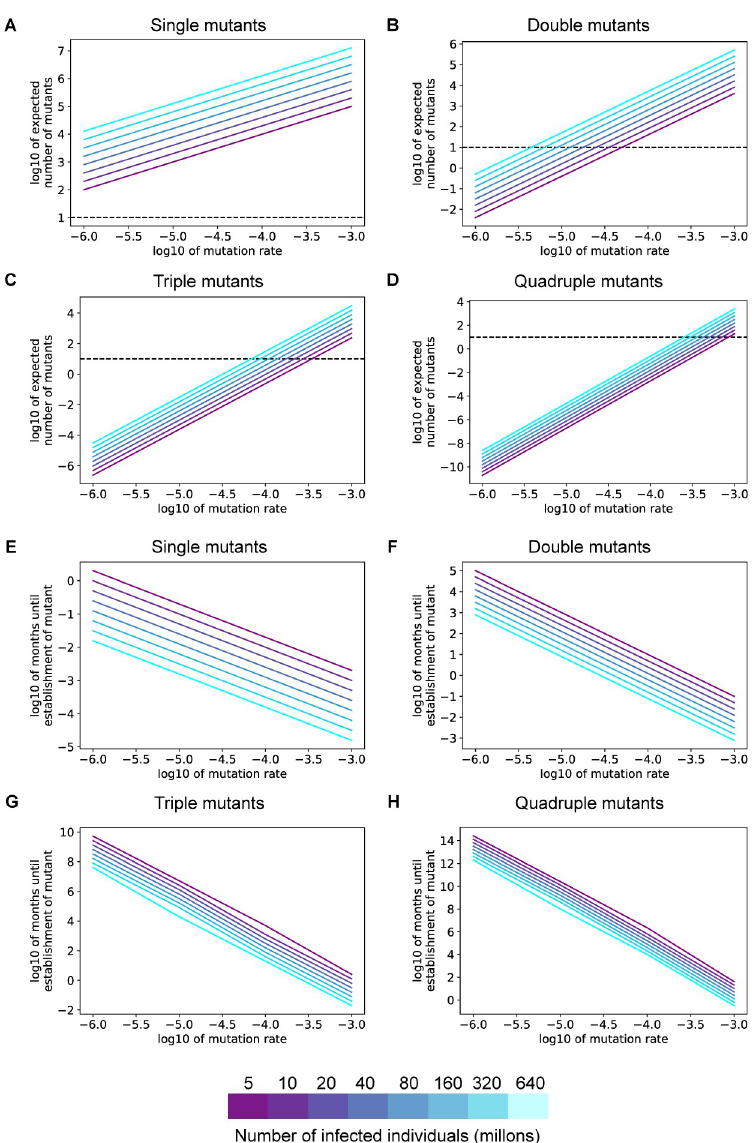
Fig 5. Resistance to single or double antibody combinations will develop quickly across a range of SARS-CoV-2 mutation rates. A-D. The expected number of individuals infected with a specific single ( A ), double ( B ), triple ( C ), or quadruple ( D ) SARS-CoV-2 mutant viruses at different values of the per transmission mutation rate. E-H. Expected time to establishment of a successful single ( E ), double ( F ), triple ( G ), or quadruple ( H ) immune escape. The fitness benefit of resistance is 0.1. For all panels, the colors denote the total number of individuals with active SARS-CoV-2 infection. The fitness cost for each intermediate mutant is